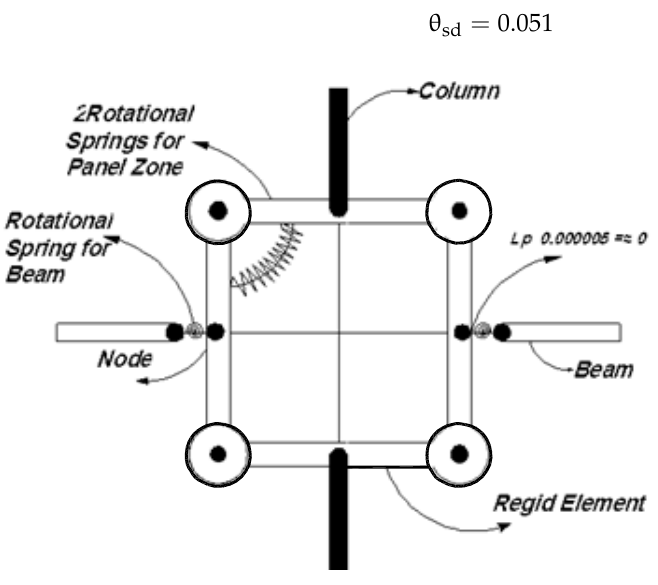
Figure 6. An overview of an example of the RBS-type connections used (conventional connections after the Northridge earthquake).